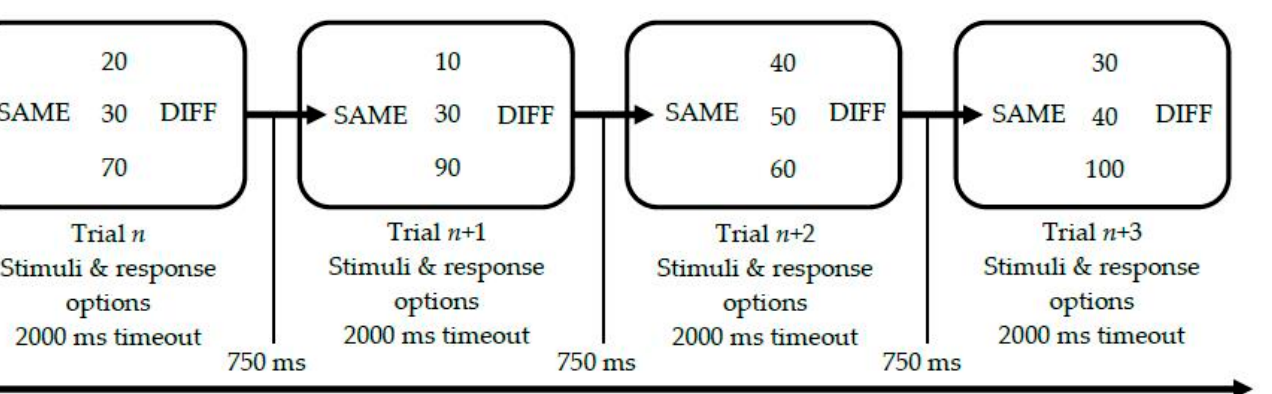
Figure 6. Trial design for condition 4 (unrelated task with no FL exposure; active